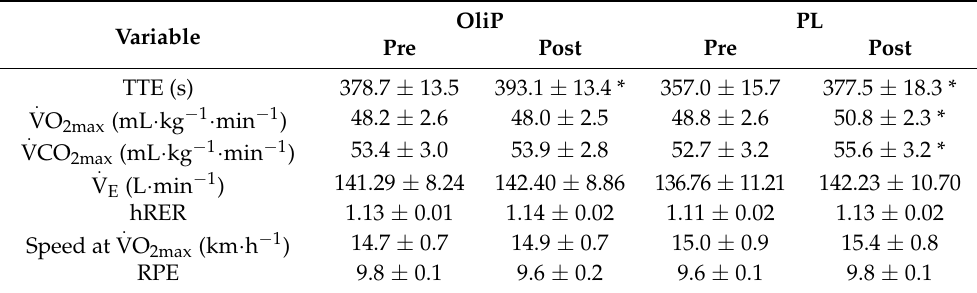
Table 7. Time to exhaustion, respiratory, exercise economy and perceived exertion parameters during maximal intensity exercise at visit 3 (pre-intervention) and 5 (post-intervention) for OliP and PL groups. OliP Variable